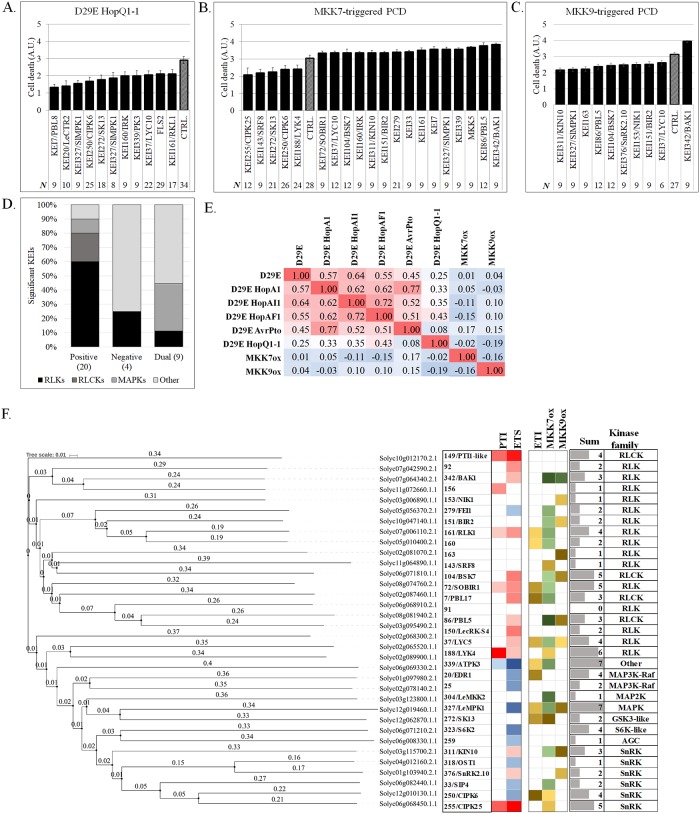
Kinases promote or inhibit cell death associated with the ETI or prolonged activation of MAPKs.A–C. Quantification of the PCD intensity in Nicotiana benthamiana KEI-silenced or EC1 control plants (CTRL) infiltrated with the ETI-inducing strain Pseudomonas syringae D29E + HopQ1-1 (A), or following overexpression of constitutively active MKK7 or MKK9 (B and C). Cell-death intensity was measured as described in Materials and methods and presented on a scale from 0 to 4 artificial units (A.U.’s). D. Histogram showing the percentages of KEIs with a positive, negative, or dual regulatory effect on cell death across kinase classes, including RLKs, RLCKs, MAPKs, and other cytosolic kinases. The number of kinases in each regulatory category is shown in parentheses. E. A heat map of the Pearson correlation coefficients (R) calculated for pairwise combinations of the eight orthogonal assays testing the defense and cell death responses in silenced plants. The map reveals similarities in KEIs’ importance for the plant response to effectorless, single-effector P. syringae strains, and cell death treatments. F. Phylogram of tomato KEIs shown alongside a phenotype heat map matrix of KEIs strength of regulation (−log10 of p-value) in bacterial inoculation assays (red: KEIs positive regulators defense; blue: KEIs positive regulators of susceptibility) and cell death–inducing treatments (brown: KEIs promoting cell death; green: KEIs inhibiting cell death). The sum column indicates the number of assays (minimum = 1 and maximum = 8) for which KEIs exhibited statistically significant phenotypes. The kinase family information is shown on the right. A.U., artificial unit; BAK1, BRI1-ASSOCIATED KINASE1; ETI, effector-triggered immunity; ETS, effector-triggered susceptibility; KEI, Kinase Effector Interactor; MAPK, MAP kinase; MKK, MAP kinase kinase; PCD, programmed cell death; PTI, PAMP-triggered immunity; RLCK, receptor-like cytosolic kinase; RLK, receptor-like kinase.